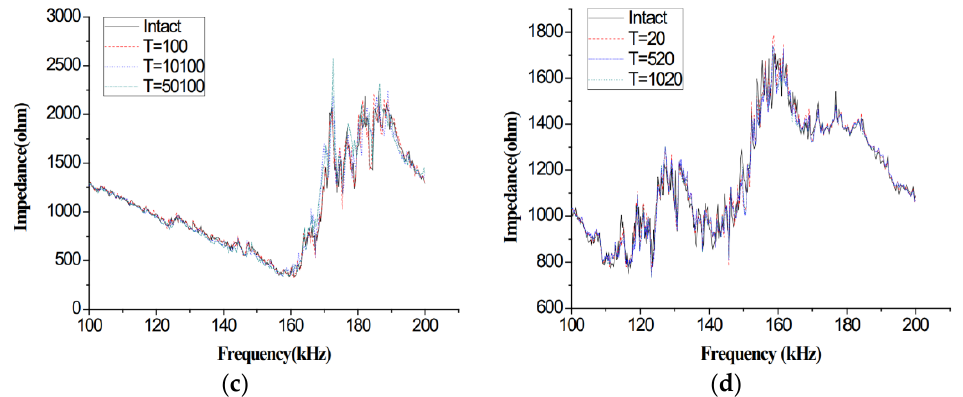
Figure 9. Difference in impedance for the four types of specimens: ( a ) welded steel plates (B03), ( b ) T-type welded steel plates (I13), ( c ) combination of plate and pipe (H09), and ( d ) combination of two steel pipes (T04).